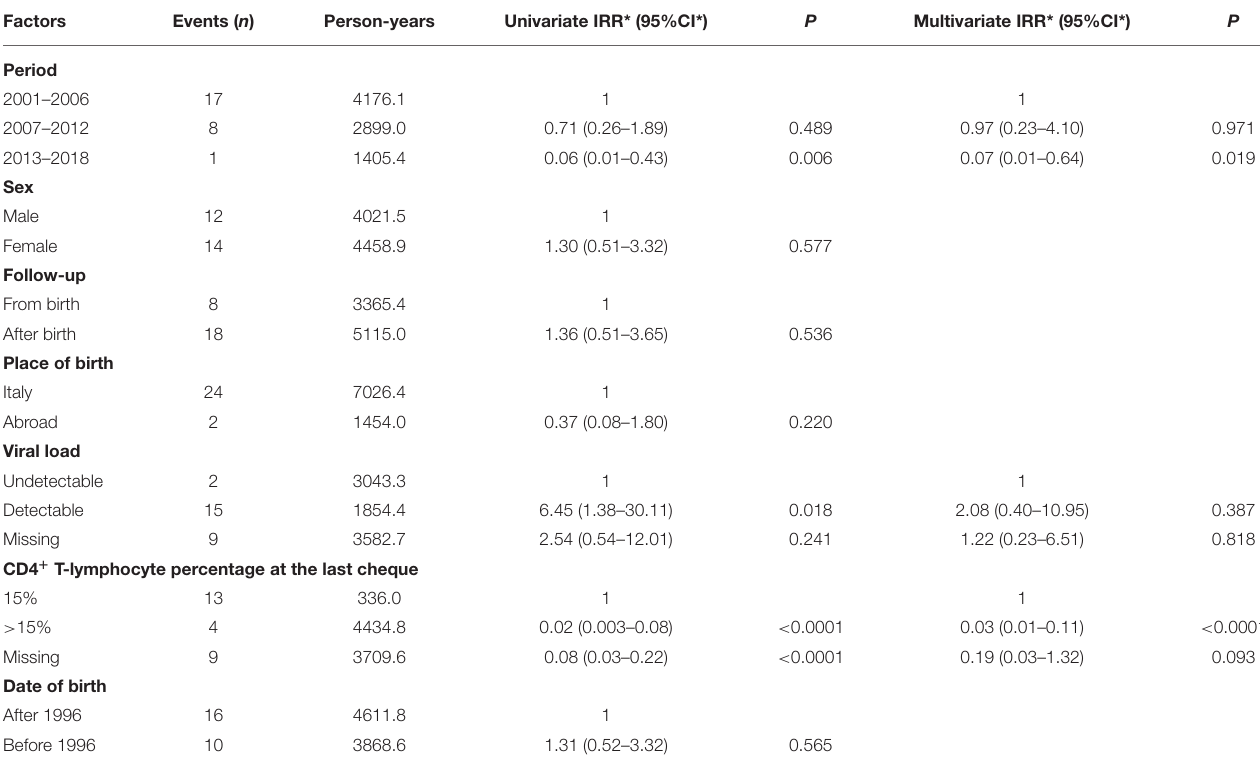
TABLE 2 | Mortality rates among the study periods adjusted for